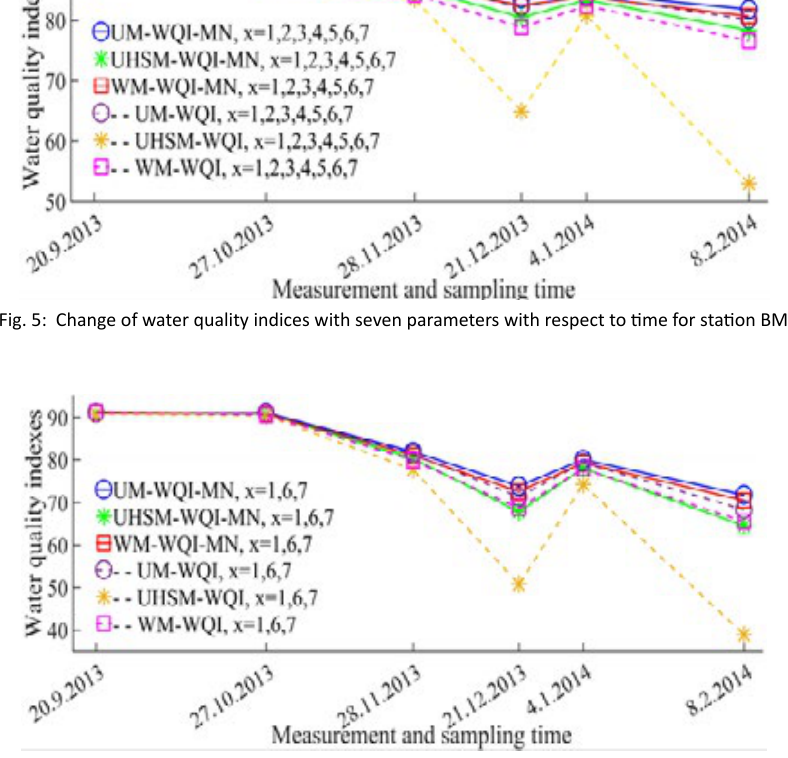
Fig. 5: Change of water quality indices with three parameters with respect to time for station BM Fig. 6: Change of water quality indices with three parameters with respect to time for station